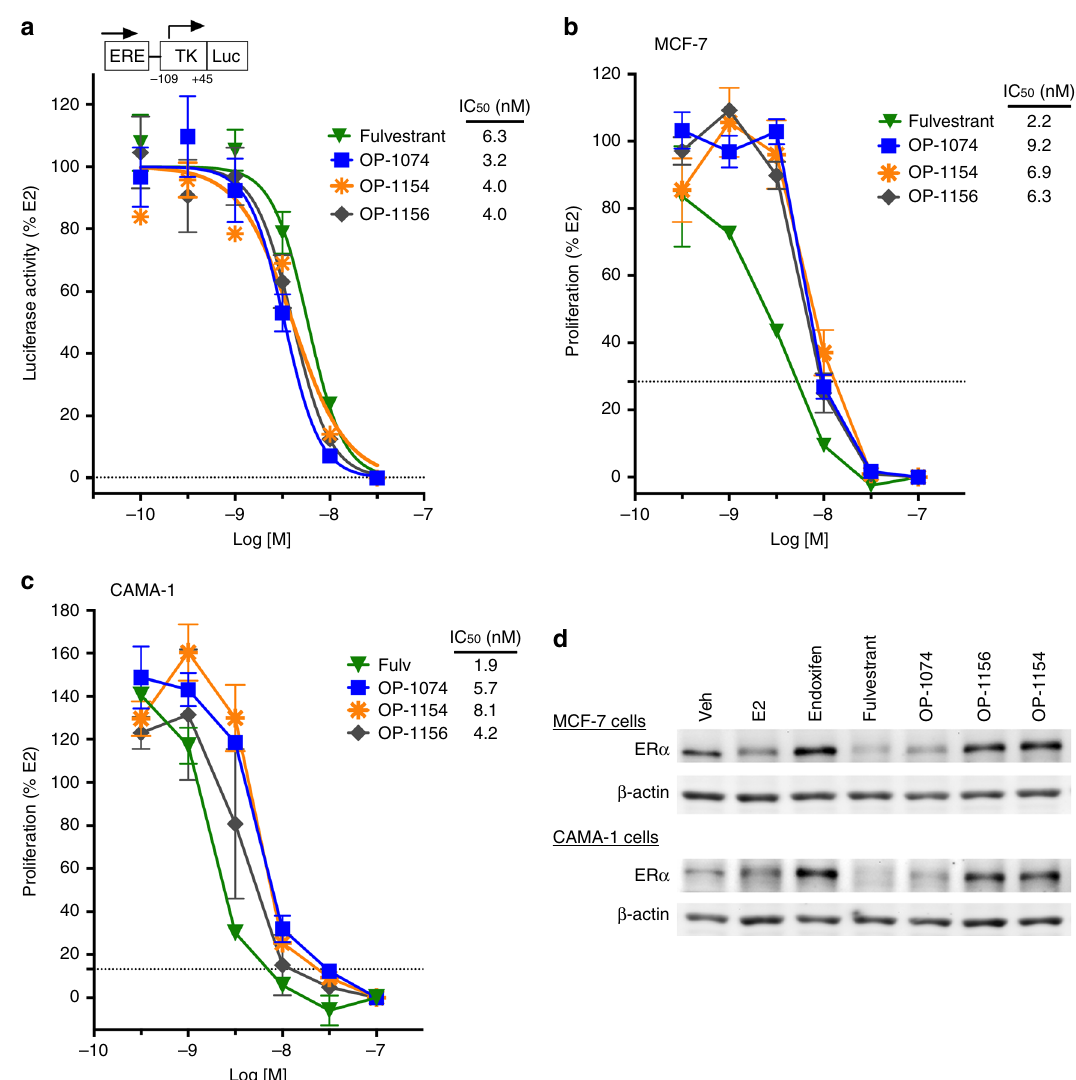
Fig. 3 OP-1074 inhibits proliferation and degrades ER α in breast cells. a , Inhibition of E2-stimulated transcription of an estrogen responsive reporter gene, ERE-tk109-Luc. Luciferase activity was assayed after treating MCF-7 cells with antiestrogens for 22 h in the presence of 100 pM E2. Shown are means + / − s.e.m. from triplicate wells of a representative experiment in which values were normalized to %E2. Dotted line represents basal activity in the absence of E2. b , c , Inhibition of E2-stimulated proliferation in breast cells. Breast cells were treated with antiestrogens in the presence of 100 pM E2 for 7 days ( b , MCF-7 cells) or 8 days ( c , CAMA-1 cells) and subsequently exposed to a fl uorescent DNA-binding dye that approximates cell number. Shown is a representative fi gure analyzed and presented as above. d , Western blot of destabilization of ER α protein by OP-1074. MCF-7 and CAMA-1 cells were treated with 100 nM ligands for 24 h and lysates immunoblotted with antibody to ER α and β show statistically signi fi cant differences (by one-way ANOVA) in their half-lives, which were closer to 4-OHT at 4.5 and 4.3 min respectively. In comparison, the t 1/2 of OP-1074 was 3.5 min; thereby exhibiting increased conformational dynamics of H12 relative to SERM compounds 4-OHT, OP-1154, and OP-1156, but decreased dynamics compared to fulvestrant. Together these data suggest that while OP-1074 may not disrupt H12 to the extent of fulvestrant, it is suf fi cient to elicit PA-SERD activity in breast cancer cells.